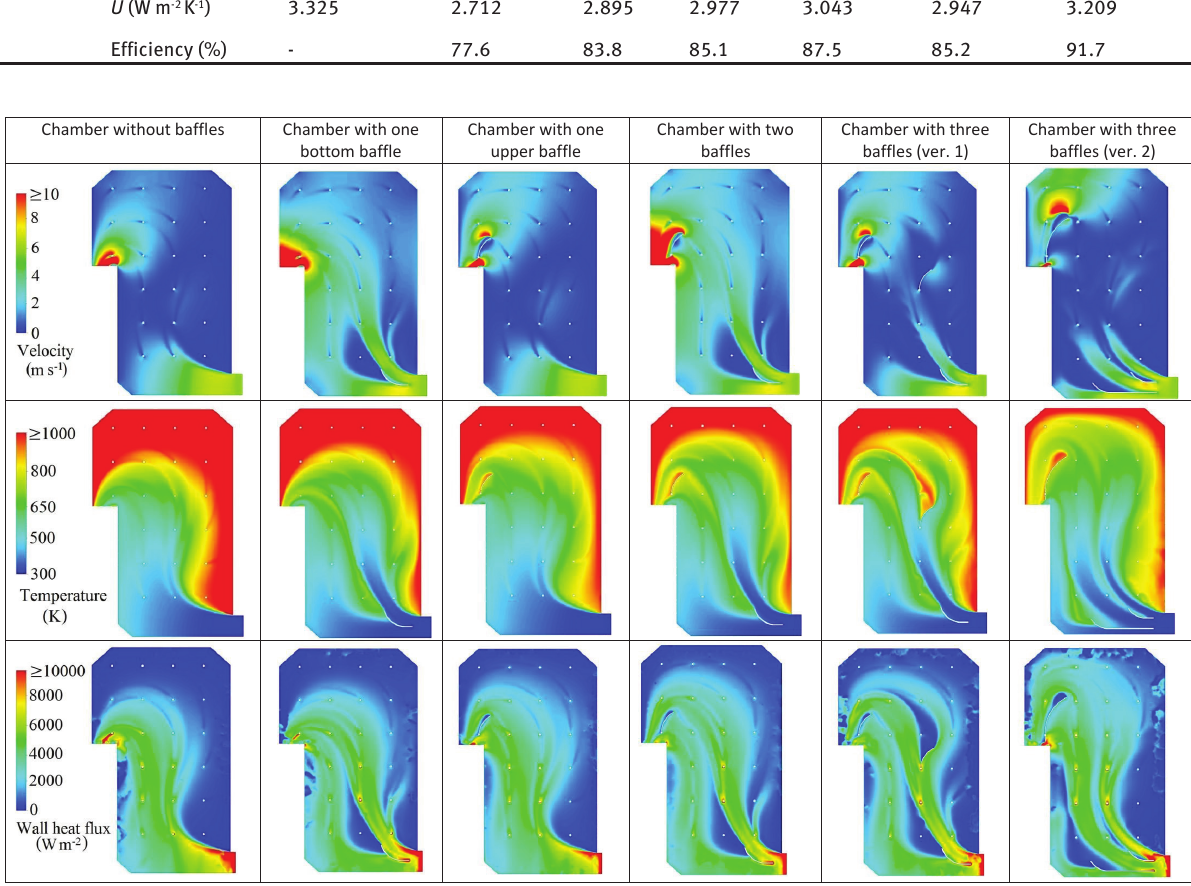
Figure 4: Results of modelling heat transfer in the chambers with different air flow patterns.